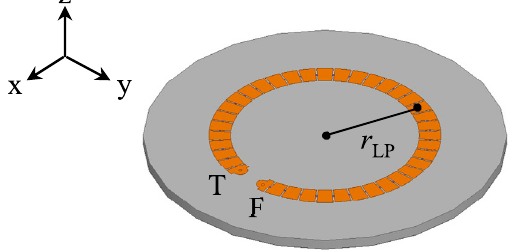
Fig. 8. Round metaloop-C antenna (RND-MTLP-C), made by curving the C-type metaline shown in Figure 2a, where N cell = 19.